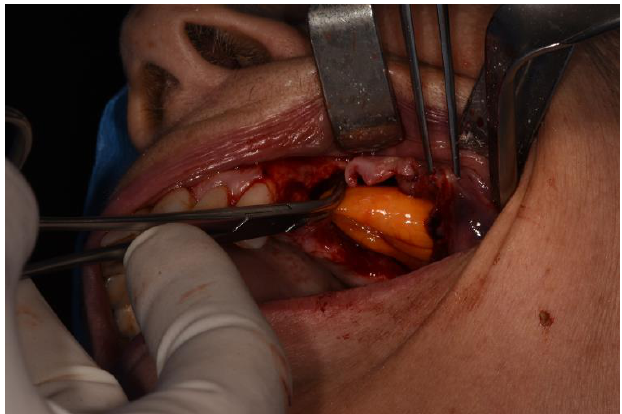
Figure 8. Buccal fat pad advancement.